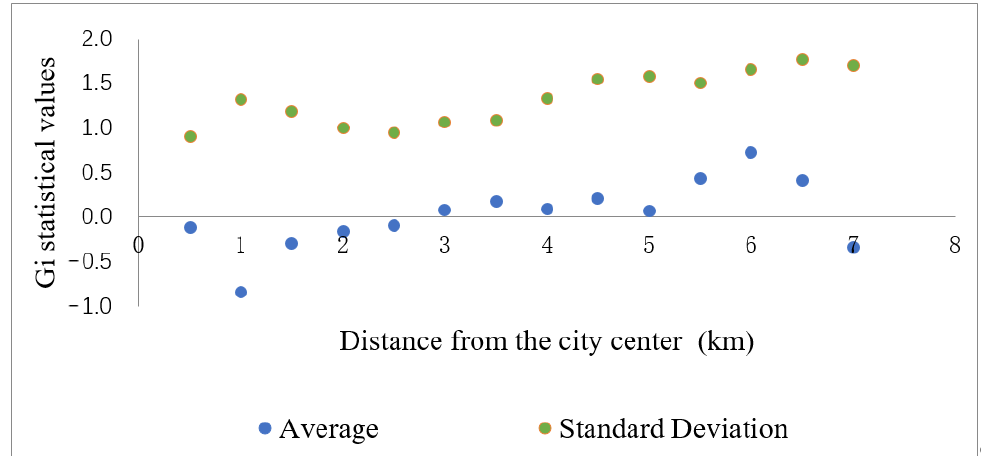
Figure 5. Gi ∗ statistics of each buffer zone in the study area. Figure 5. (cid:1833)(cid:1861) ∗ statistics of each buffer zone in the study area.